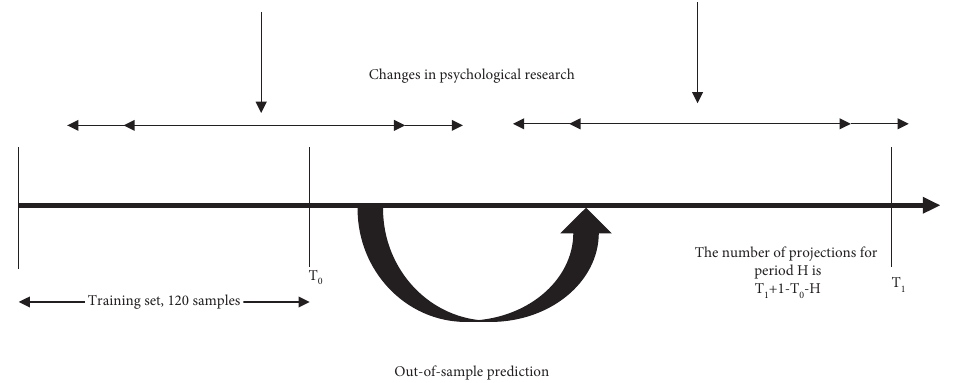
Figure 3: Schematic diagram of out-of-sample prediction